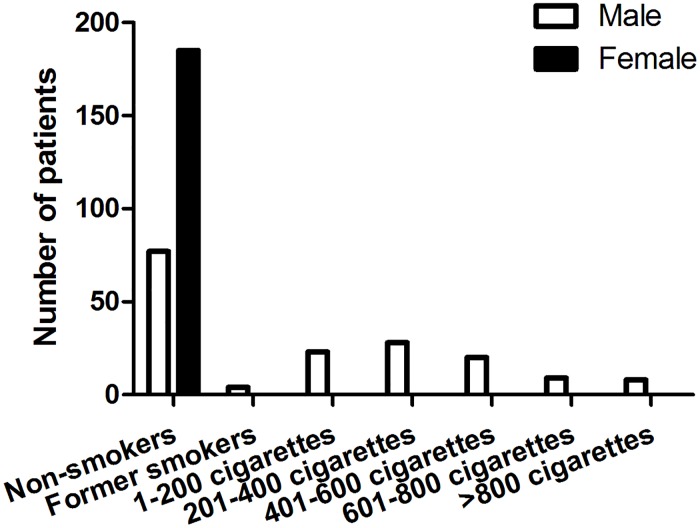
Smoking status of the patients with TAO.